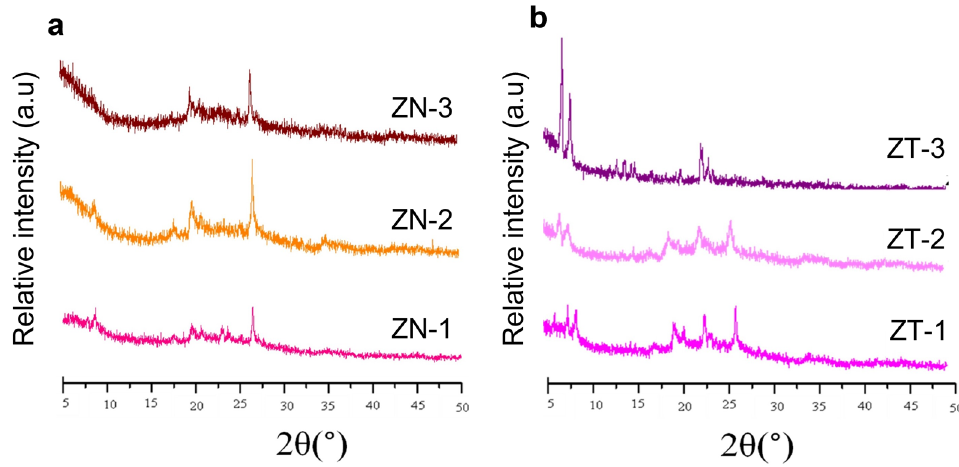
Figure 3. XRD analysis of ZSM-5 synthesized using NaOH ( a ) and TPAOH ( b ) as template.